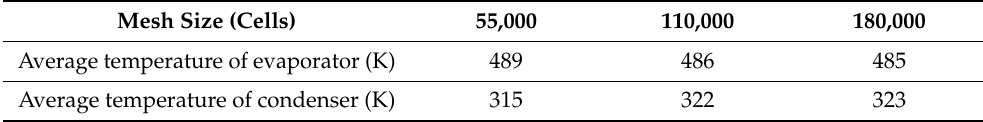
Table 7. The results of the grid independency for CFD study of oil in